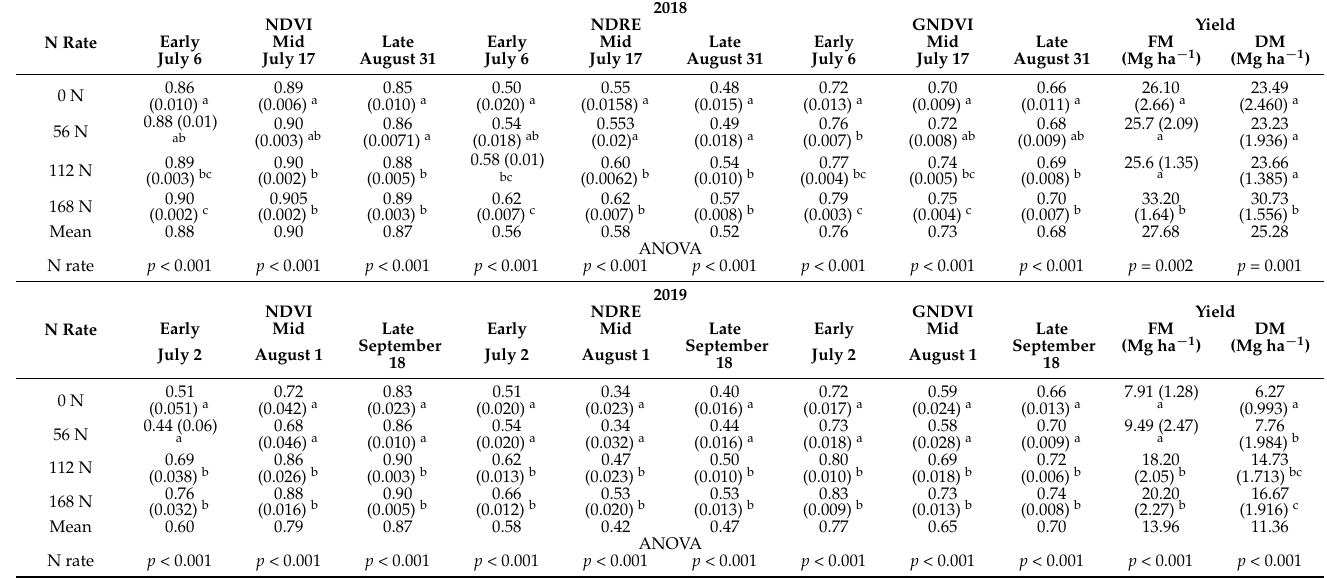
Table 4. Average NDVI, NDRE, GNDVI, dry matter (DM) yield, and fresh matter (FM) (Mg ha − 1 ) yield in response to nitrogen in 2018 and 2019 obtained from four 1 m × 1 m quadrats in Urbana, IL, USA. Numbers in parenthesis indicate standard error of the differences in means when analyzed by sampling date. Different letters indicate statistical differences in means due to N at p < 0.05.